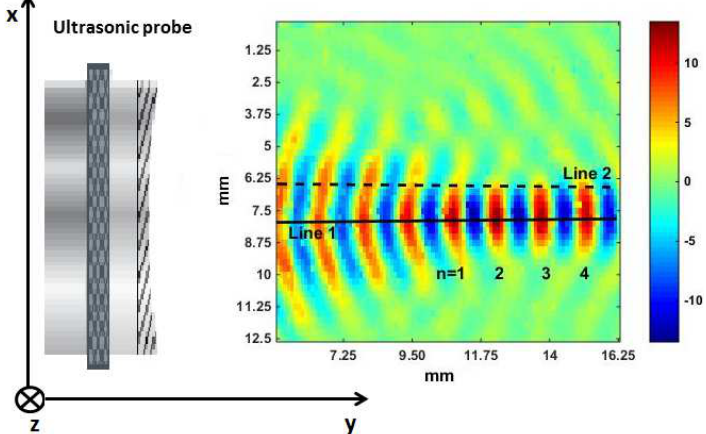
Figure 6. LDV visualization of the focused transducer Panametrics V303 for the frequency of 1 MHz. Line 1 indicates points situated in the center of the beam diameter, while Line 2 represents points at the beam border. The variable n indicates wavefronts situated in the focal region.